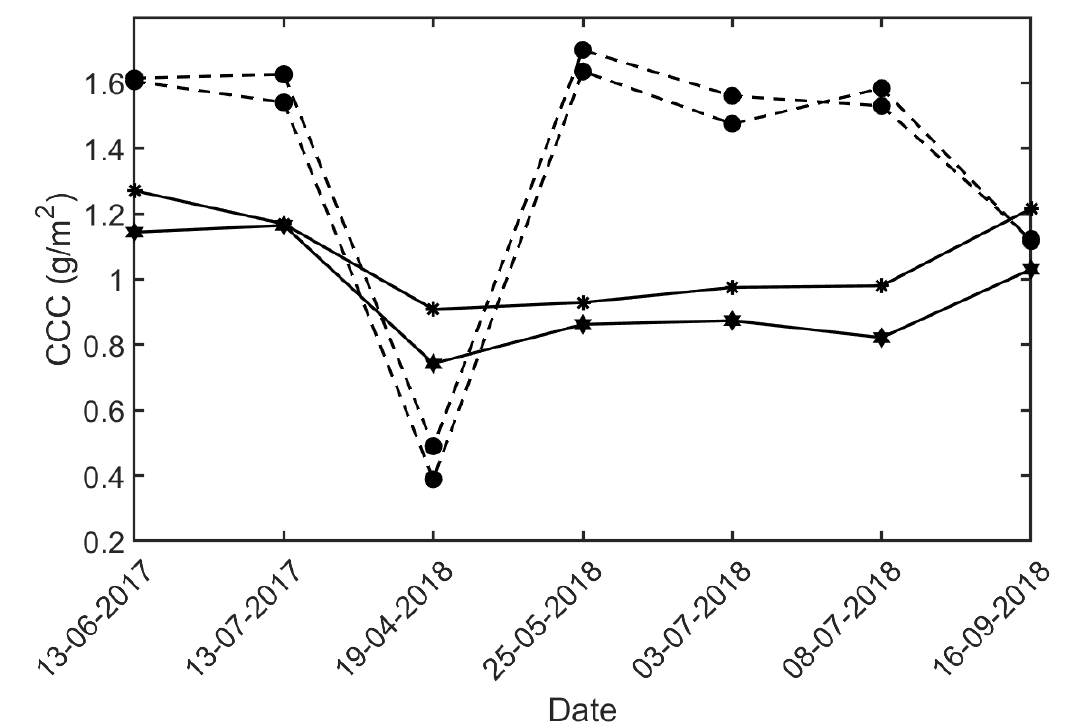
Figure 8. Seasonal variability of CCC between June 2017 and September 2018 in the Bavarian Forest National Park. The broken lines show the seasonal variation in broadleaf stands, and the solid lines in a conifer stand for randomly selected two pixels.